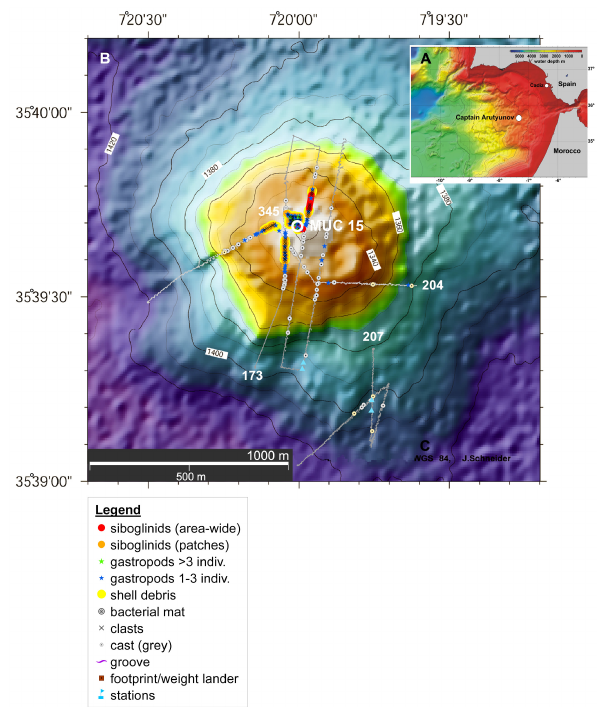
Fig. 1. (A) Location of the mud volcano Captain Arutyunov in the Gulf of Cadiz. (B) Bathymetric map of the Captain Arutyunov mud volcano with indications of major distribution patterns of fauna and lithogenic features. (C) Methane concentrations measured 5m above the sea floor.